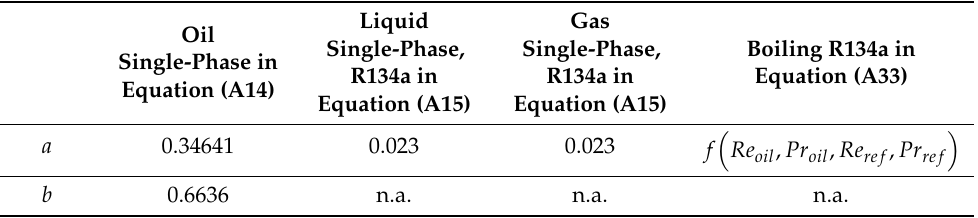
Table A3. The calculated empirical coefficients of the thermal model of the